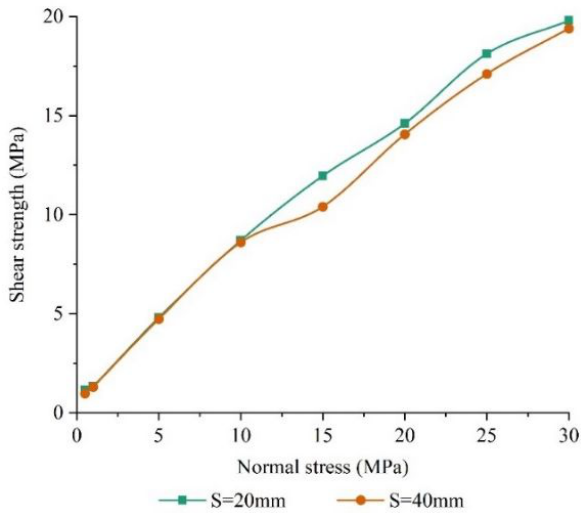
Figure 12: Relationship between shear strength and normal